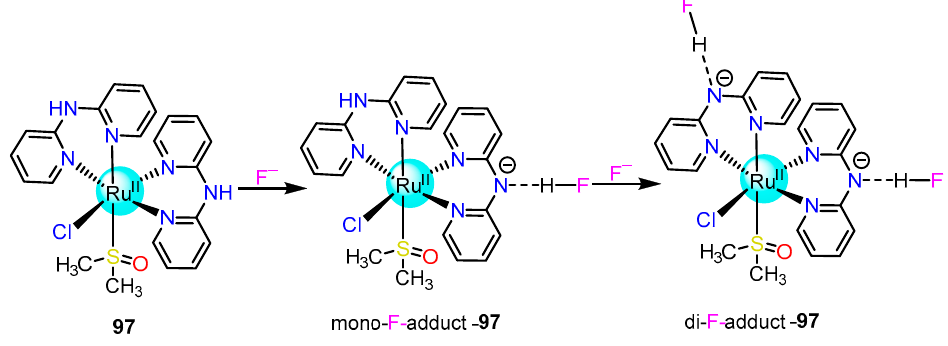
Scheme 7. Formation of mono and di-F − adduct of